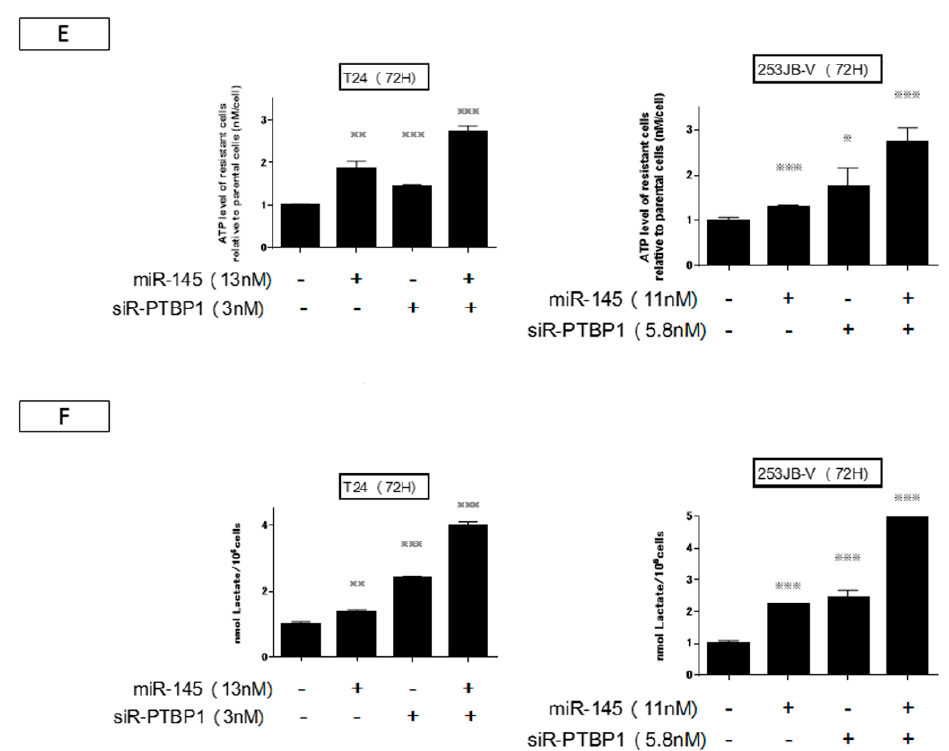
Figure 5. Combination treatment contributed to the greater and longer growth inhibition compared with each single-treatment. ( A , B ) The graph showed a time-course and at 72 h of cell growth after treatment with miR-145 and/or siR-PTBP1. Combination treatment inhibited cell growth greater and deeper than single-treatment. CI: Combination index. The combination index theorem of Chou-Talalay was used as a quantitative definition for additive (CI = 1) and synergistic (CI < 1) effects of drug combinations. ( C , D ) The expression of growth and Warburg effect-related proteins examined by Western blot analysis and mRNA levels of c-Myc and PTBP1 examined by RT-PCR in T24 and 253JB-V cells at 72 h after miR-145 and/or siR-PTBP1 were shown. ( E , F ) Intracellular ATP and lactic acid levels were measured at 72 h after the transfection of T24 and 253JB-V cells with miR-145 and/or PTBP1. * indicates p < 0.05; ** p < 0.01; *** p < 0.001.